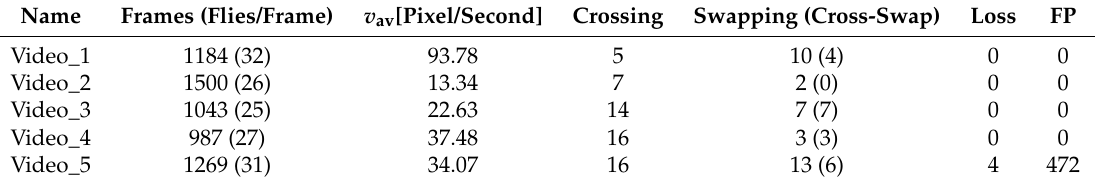
Table 1. Error of flies swapping. The first column is the video name. The second column shows the number of frames with the number of flies per frame. The third column shows average velocity. The forth column is the number of crossing events that occurred in each video. The fifth column shows the total number of swapping occurrences with the number of swaps from crossing events in parentheses. The sixth column represents the number of loss of identity events. The last column is the total number of false positives